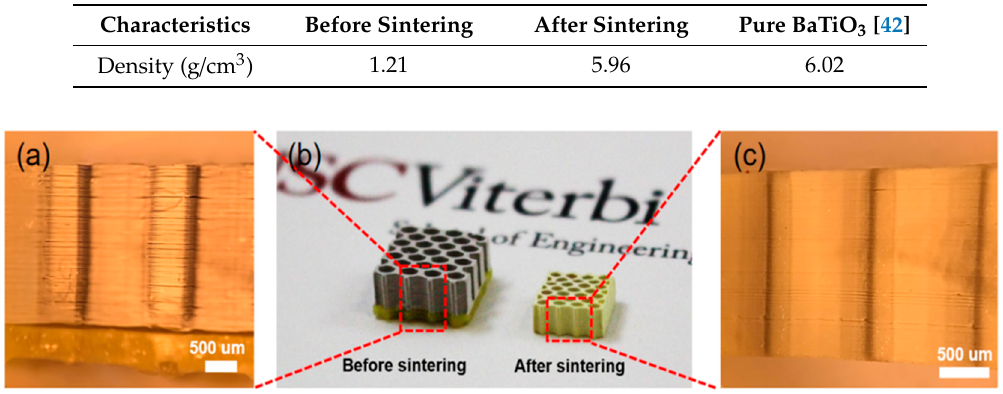
Figure 4. ( a ) Layer details of the sample before sintering. ( b ) Size comparison of the samples before and after sintering. ( c ) Layer details of the sample after sintering.